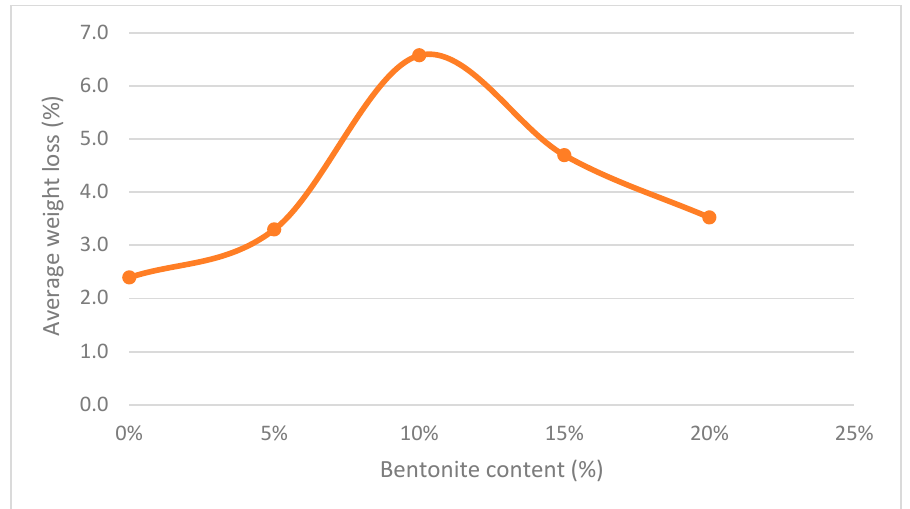
Figure 5. Average weight loss of AC with bentonite variation after 8 weeks of FT cycles.